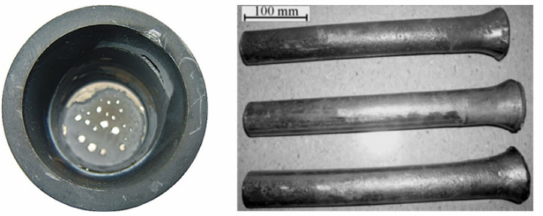
Figure 1. Graphite crucible and manufactured ingots of Ti-47Al-2W-0.5Si